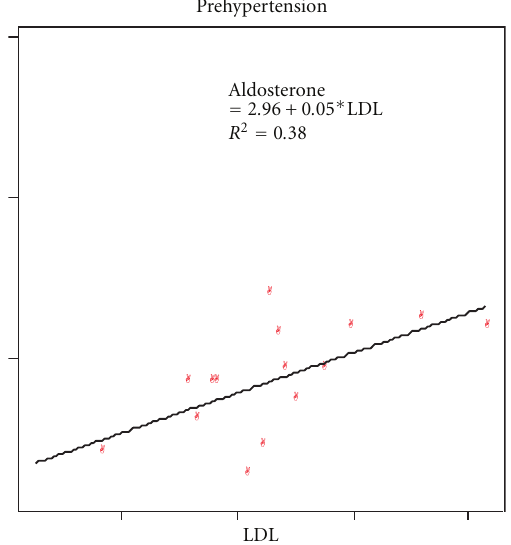
Figure 4: Correlation between low density lipoproteins (LDL) and